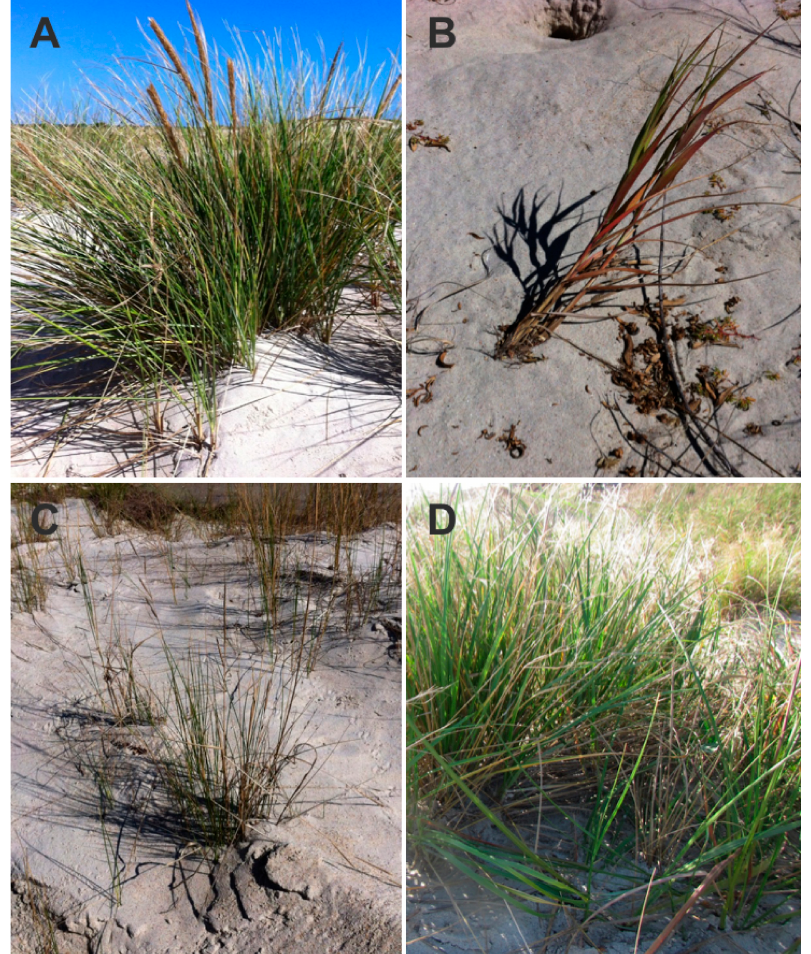
Figure 1. Photographs of the four most common dune grass species ( A ) Ammophila breviligulata (American beachgrass), ( B ) Panicum amarum (bitter panicum), ( C ) Spartina patens (saltmeadow cordgrass), and ( D ) Uniola paniculata (sea oats) in foredunes of the Outer Banks islands from Virginia to North Carolina, USA. Photos by S. D. Hacker.